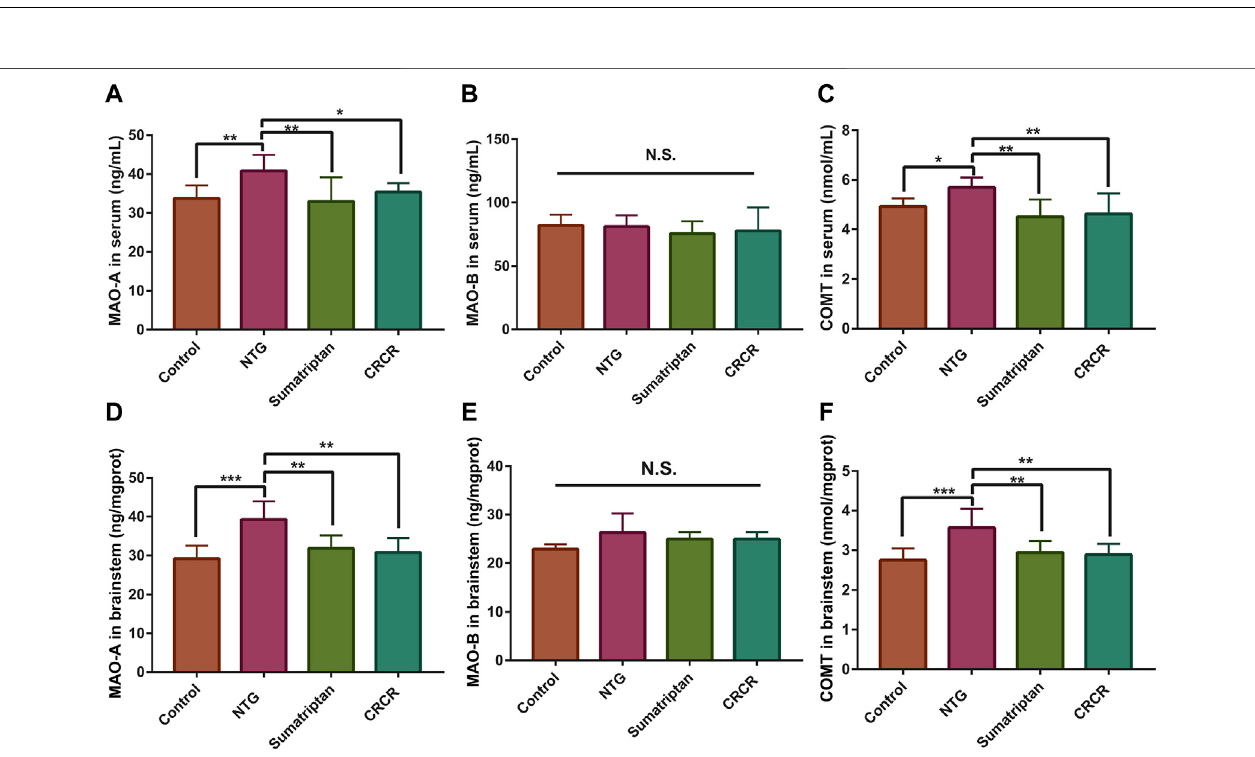
FIGURE 8 | The contents of monoamine oxidase A (MAO-A), monoamine oxidase B (MAO-B), and catechol- O -methyltransferase (COMT) in rat serum and brainstem. (A) MAO-Ainserum. (B) MAO-Binserum. (C) COMTinserum. (D) MAO-Ainbrainstem. (E) MAO-Binbrainstem. (F) COMTinbrainstem.Dataareexpressed as mean ± S.D. * p < 0.05, ** p < 0.01, *** p < 0.001, **** p < 0.0001.